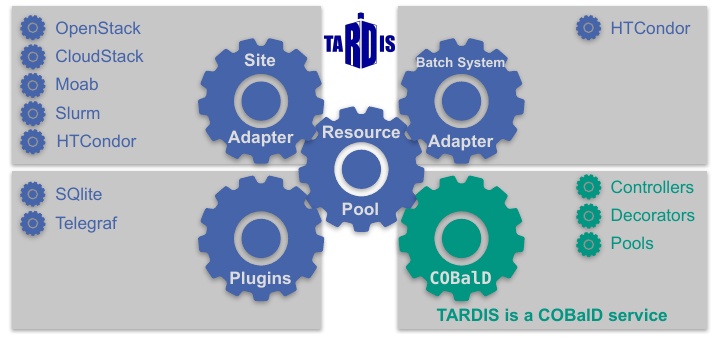
Figure 2. Modular and easily extendable design of the TARDIS resource